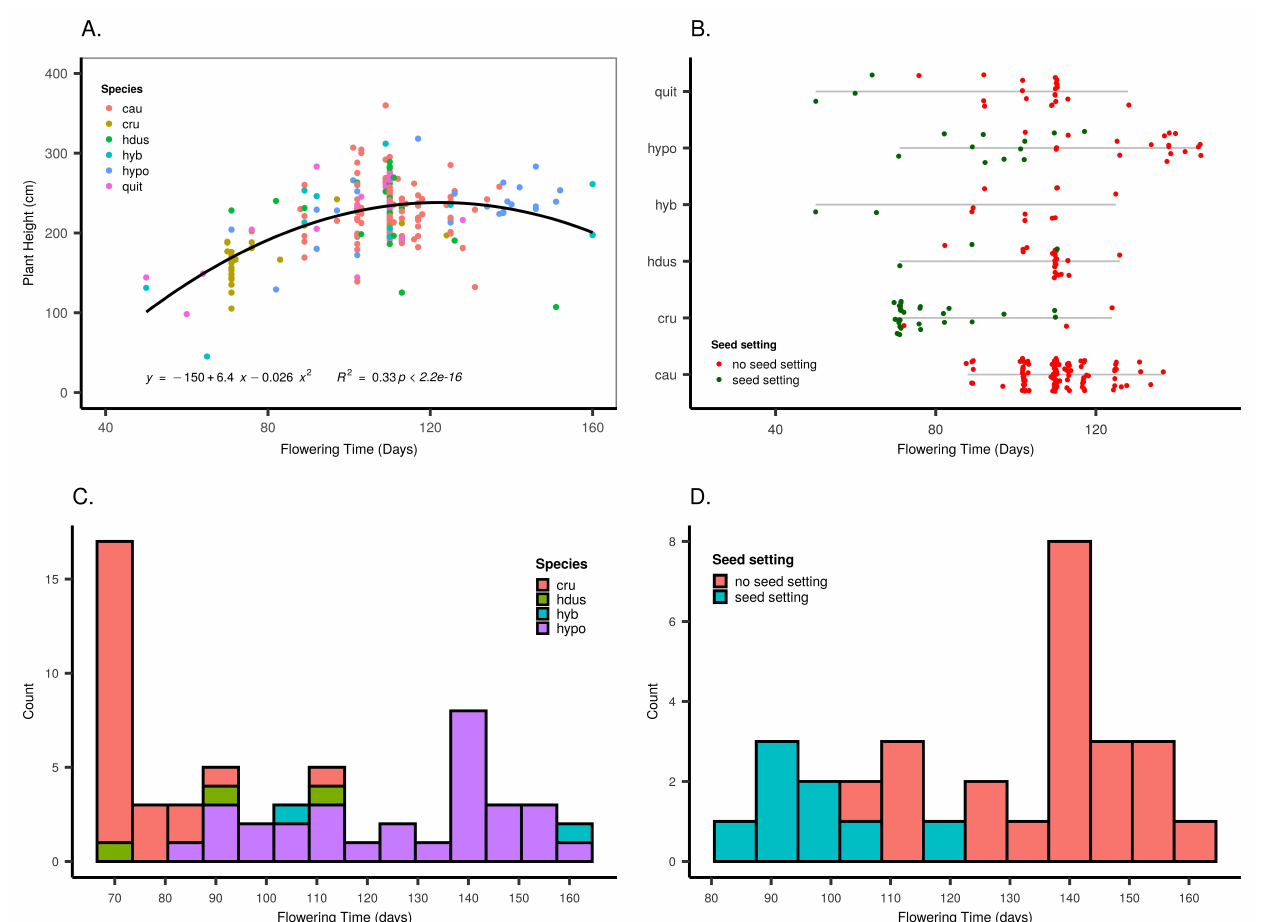
Figure 4. ( A ) The polynomial relationship between flowering time and plant height. ( B ) Dot plot of flowering time. Y axis indicates the species and X axis indicates the flowering days. Each dot corresponds to an accessions flowering time and the color of the dot indicates if the flowering event occurring on the corresponding day resulted in seed setting (green color) or no seed setting (red color). ( C ) Flowering time histogram of the Central American accessions grouped by species. ( D ) Flowering time histogram of the Central American A. hypochondriacus accessions grouped by seed setting